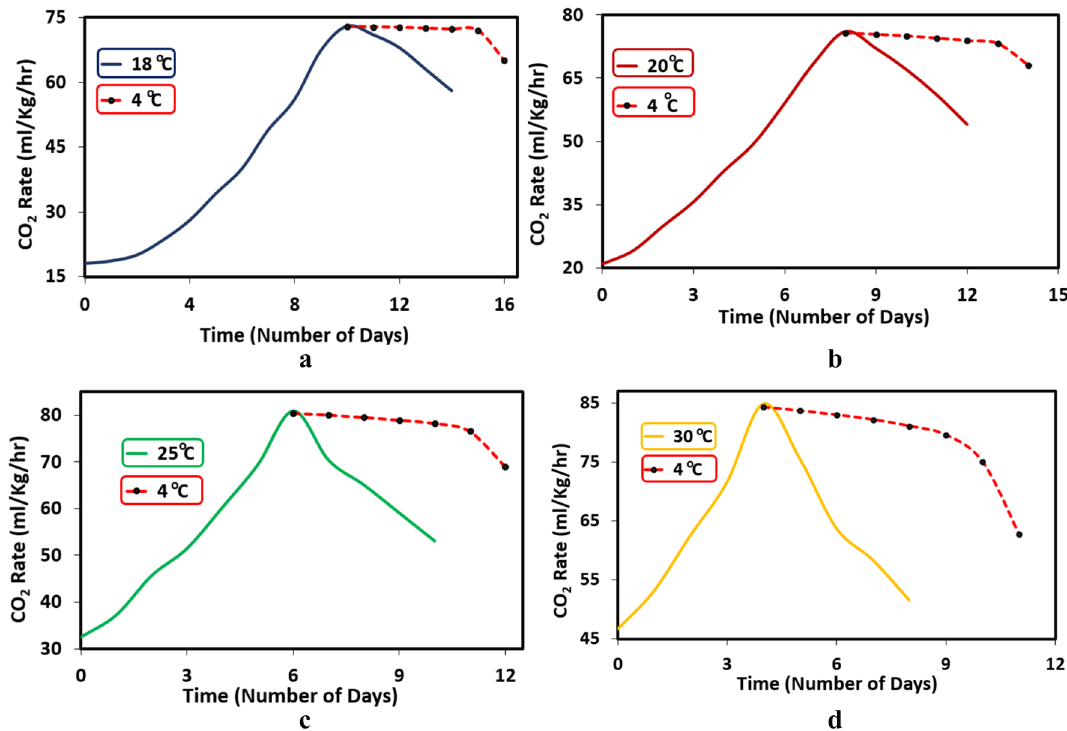
Fig. 4 Variation of CO rate over time a under different storage temperatures a 18 °C, b 20 °C, c 25 °C, d 30 °C followed by storage at 4 °C 2